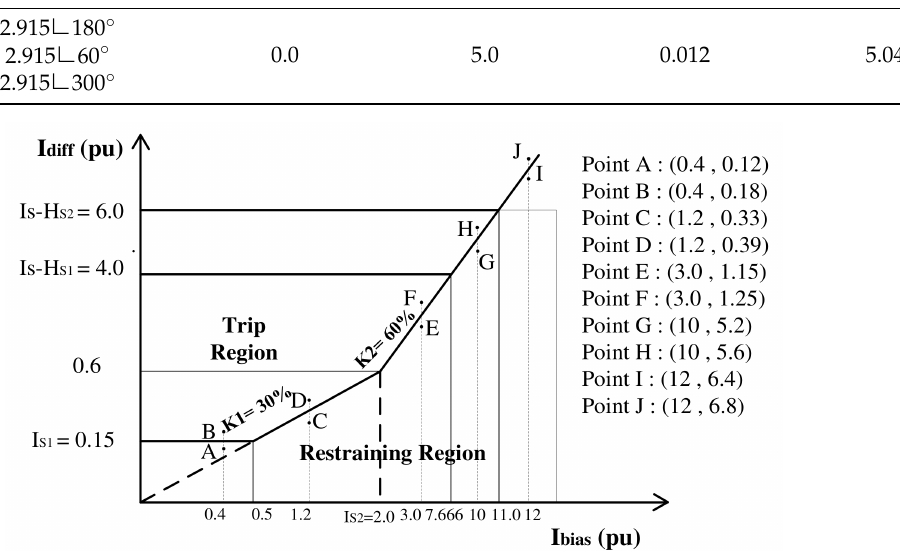
Table 12. The injected three phase HV and LV fault currents into relay result into 𝐼 (cid:3031)(cid:3036)(cid:3033)(cid:3033) =